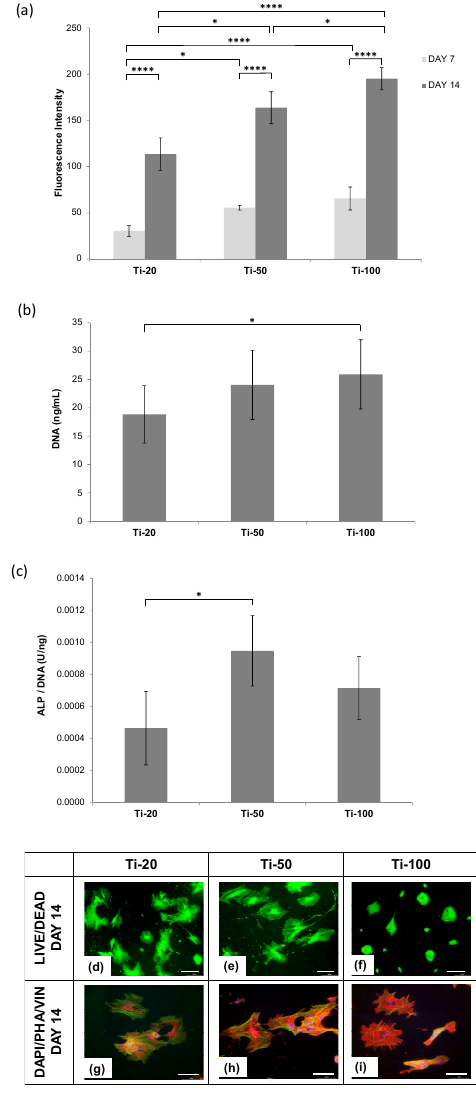
Figure 4. ( a ) AlamarBlue TM metabolic activity of human osteoblasts (HOBs) cultured on anodised titanium samples with respective pore diameter at Day 7 and 14 in Osteoblast Growth Medium. Values are mean ± S.D., n = 4, * p < 0.05, **** p < 0.001; ( b ) DNA content of human osteoblasts (HOBs) measured using PicoGreen assay, cultured on anodised titanium samples with respective pore diameter at Day 14 in Osteoblast Growth Medium; ( c ) Normalised alkaline phosphatase (ALP) activity per DNA of human osteoblasts (HOBs) cultured on anodised titanium samples with respective pore diameter at Day 14 in Osteoblast Growth Medium. For ( b , c ) Values are mean ± S.D., n = 4, * p < 0.05; LIVE / DEAD cell viability microscopy ( d – f ) with green stained live cells and immunofluorescence microscopy ( g , h ) with cell nuclei (blue), F-actin cytoskeleton (green) and vinculin (red) of human osteoblasts (HOBs) cultured on anodised titanium samples with respective pore diameter at Day 14 in Osteoblast Growth Medium. Scale bar = 100 µ